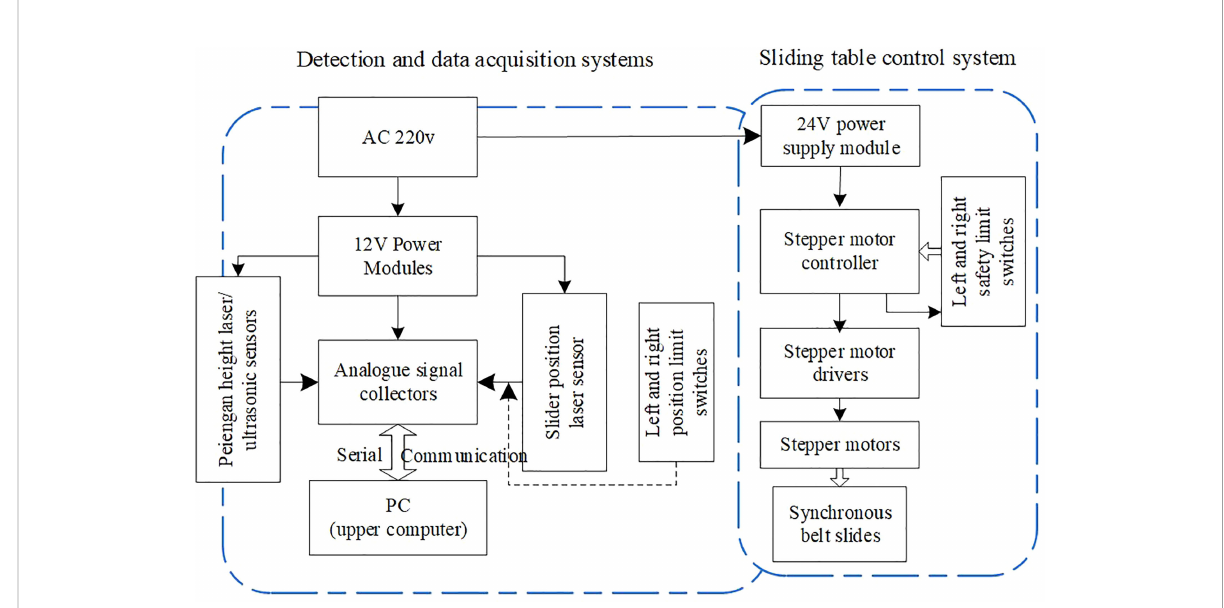
FIGURE 2 Block diagram of boom height probing platform. The test platform for ultrasonic sensor to detect the height of spray boom mainly includes sliding table unit and ultrasonic sensor detection unit, which can meet the static and dynamic ultrasonic detection test